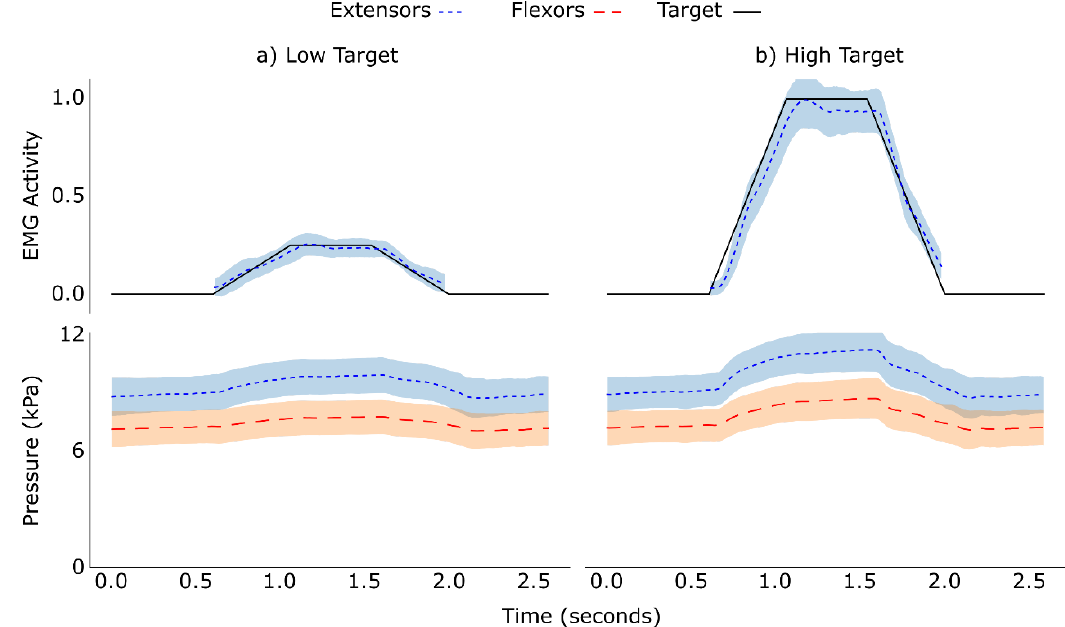
Figure 5: The mean EMG recording and corresponding pressure recordings from the extensors (shown in blue) and flexors (shown in red) from a) the low target trials and b) the high target trials, across all compressed trials from all participants. The black line represents the EMG target height, and the shaded bands show the standard deviation. For the EMG recordings, only the period where the target is rising, held, or falling in height is shown, as participants where not assessed outside of this period. The pressure recorded above the extensors was consistently around 2kPa (15 mmHg) higher than the pressure recorded above the flexors due to anatomical differences described in detail in section